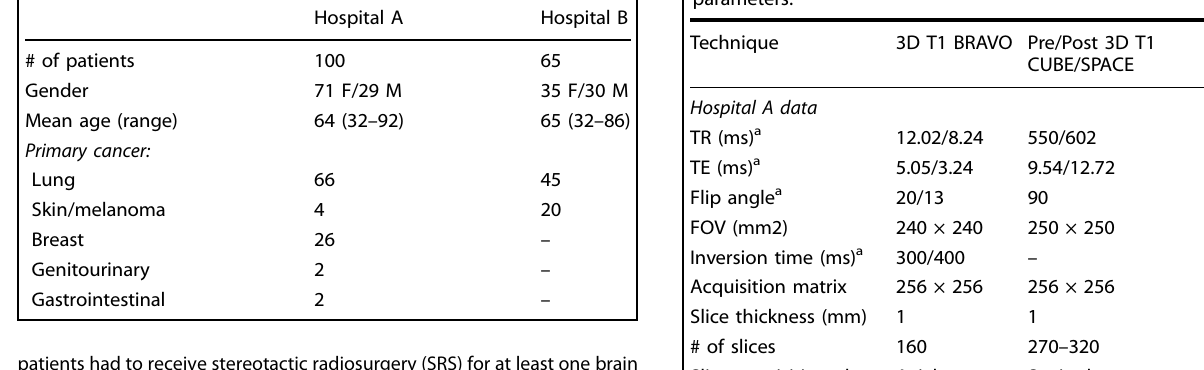
Table 2. Patient demographics. Table 3. Overview of MRI pulse sequences and key imaging